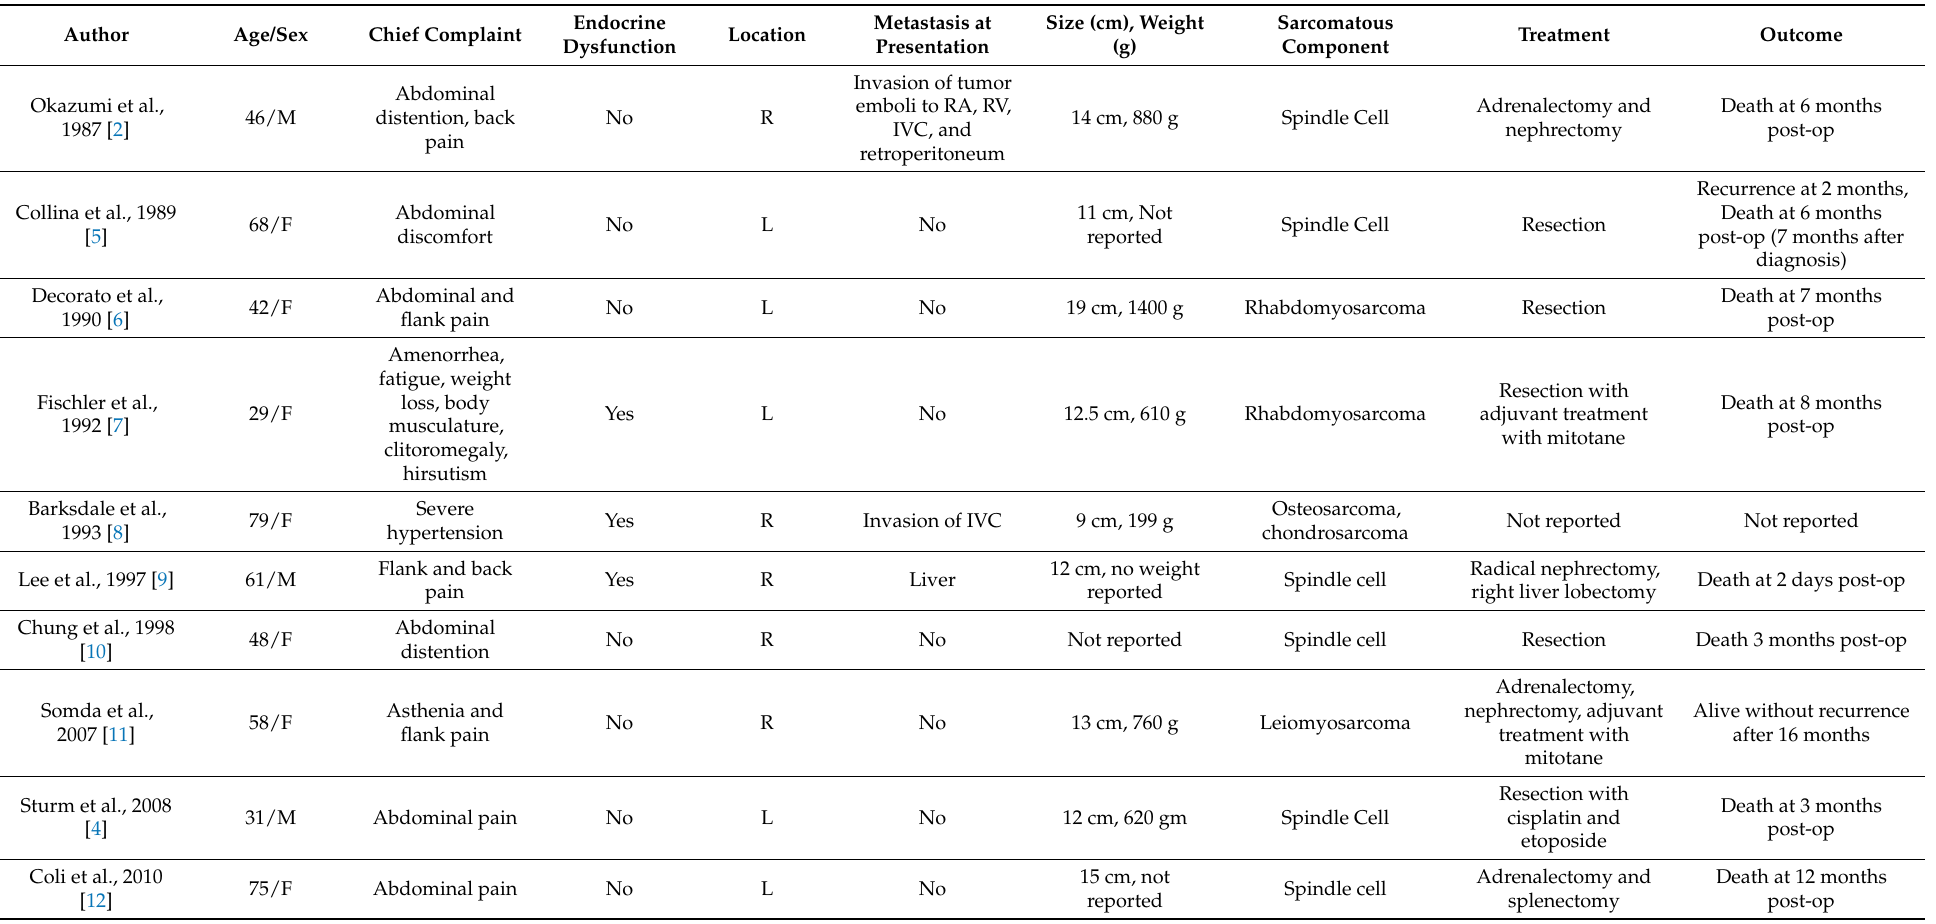
Table 2. Clinicopathologic features and outcomes of reported cases of adrenal cortical carcinosarcoma. Abbreviations: M, male; F, female; R, right; L, left; RUQ, right upper quadrant; RA, right atrium; RV, right ventricle; IVC, inferior vena